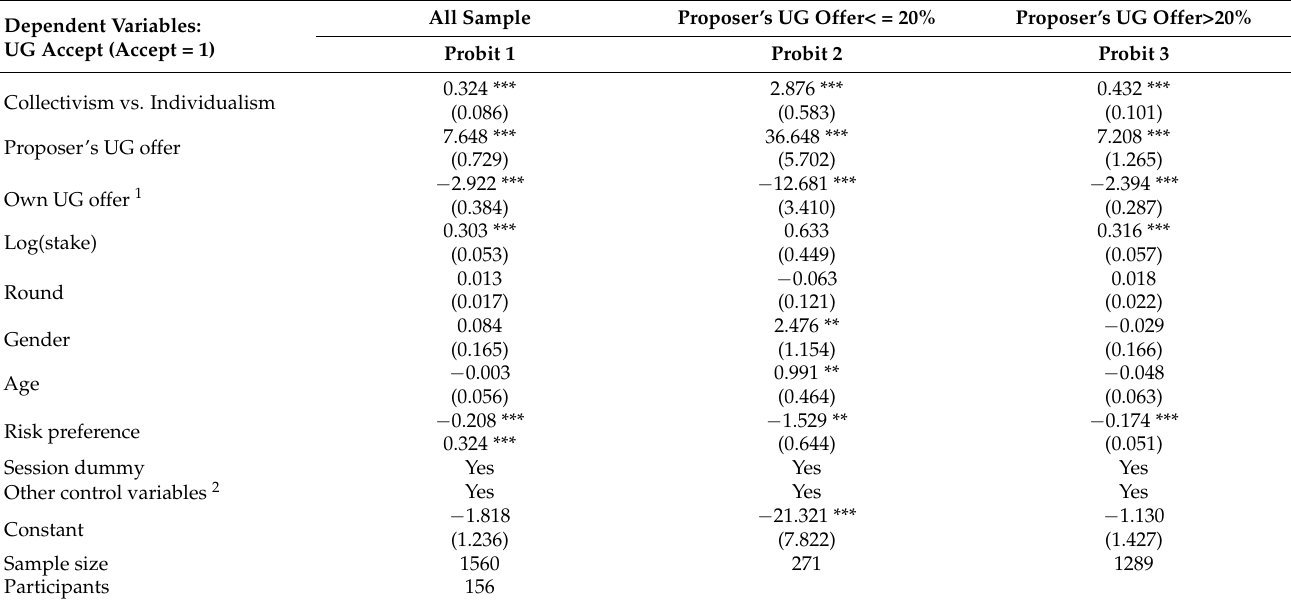
Table 4. Regression analysis of two treatments of responders’ behavior.